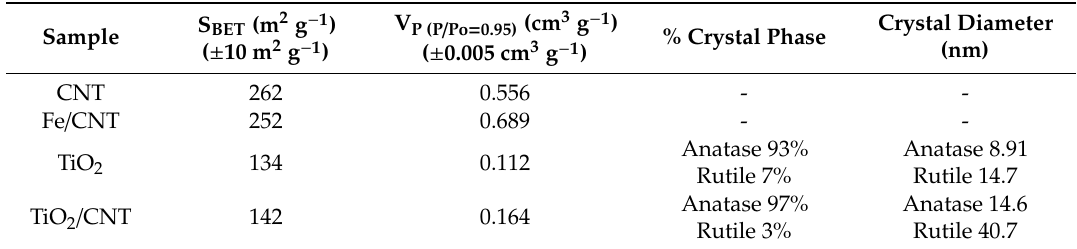
Table 2. Textural properties of the prepared catalysts and crystal properties of TiO 2 and TiO 2 /carbon nanotube (CNT) samples.